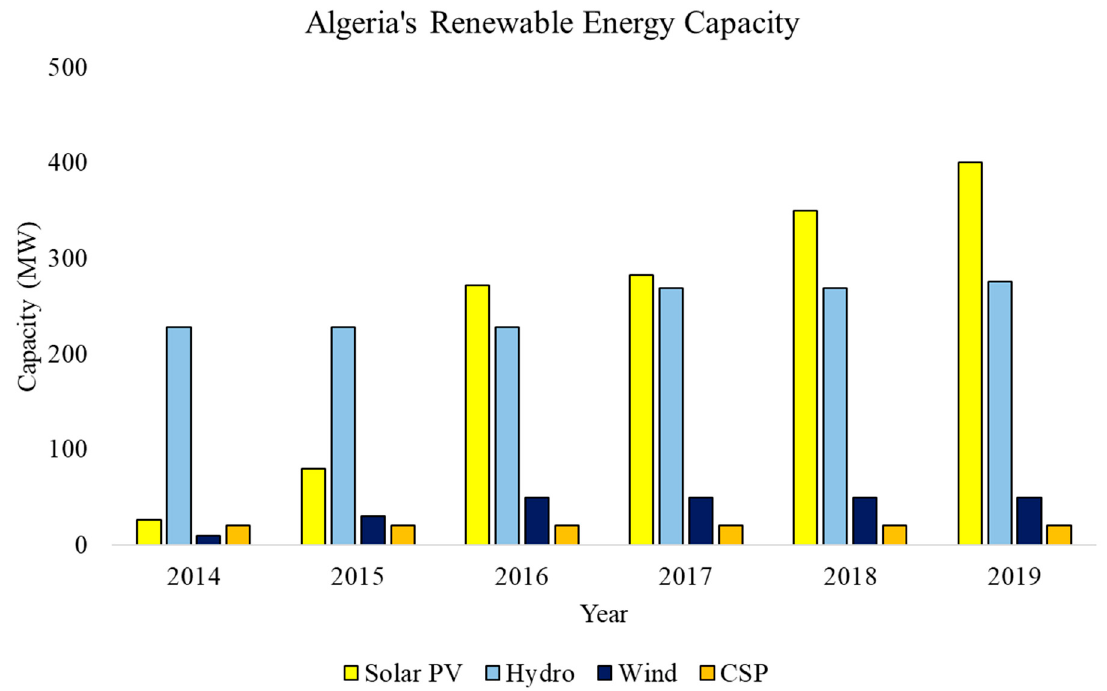
Figure 16. RE installed capacity in Algeria from 2014 to 2019.